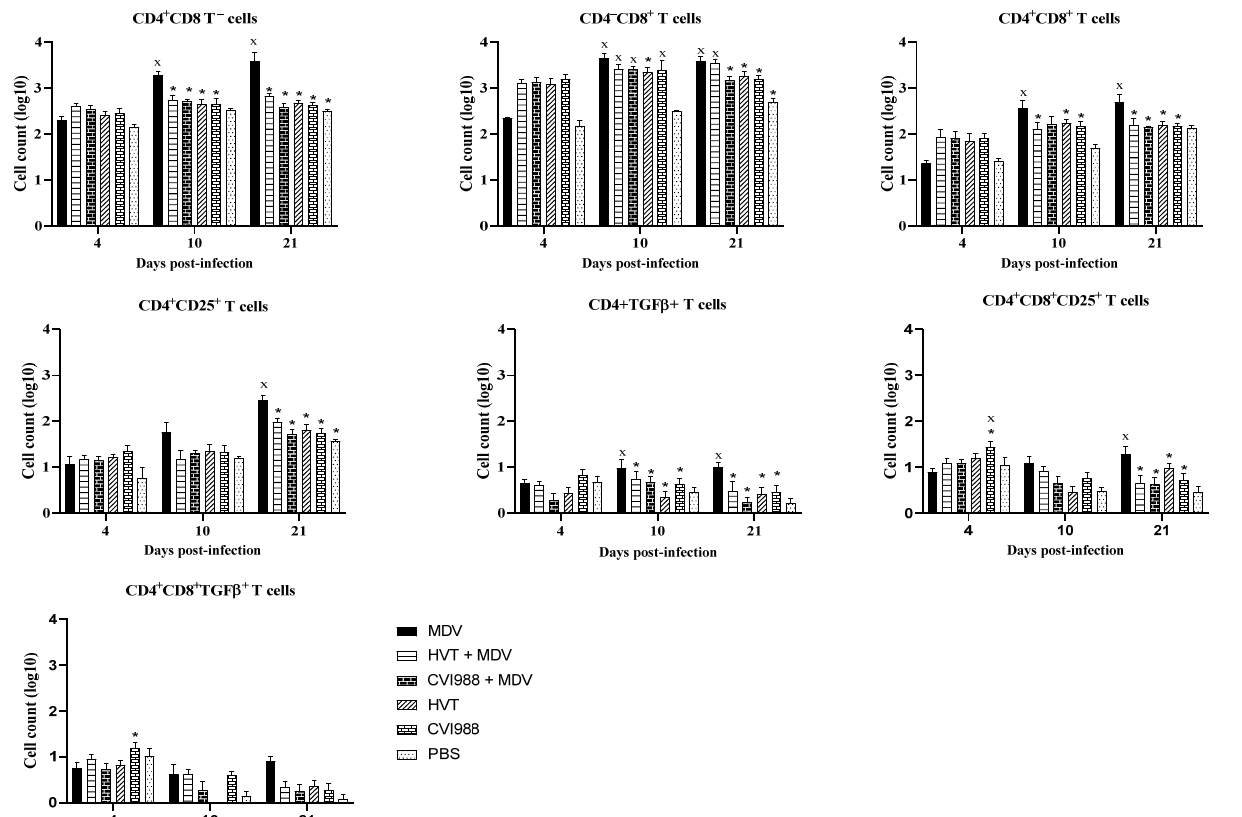
Figure 2. Evaluation of subsets of T cells in feathers ( n = 6) at 4, 10, and 21 dpi. Cells were isolated from the feather pulp from feather tips, and analyzed by flow cytometry at various time points following the MDV challenge. Two-way ANOVA and Tukey’s multiple comparison test were used to analyze these data. If p -value was ≤ 0.05, it was considered statistically significant when compared with PBS (x) or MDV (*). Cell counts on the Y -axis are presented on a logarithmic scale. Error bars indicate mean ± standard error.